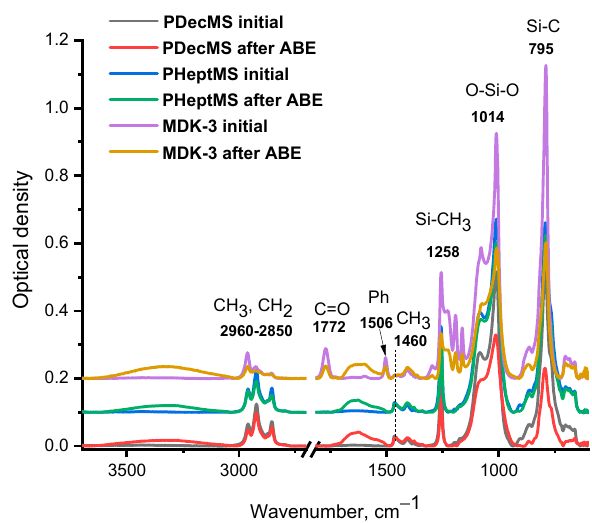
Figure 6. IR spectra of the membranes.